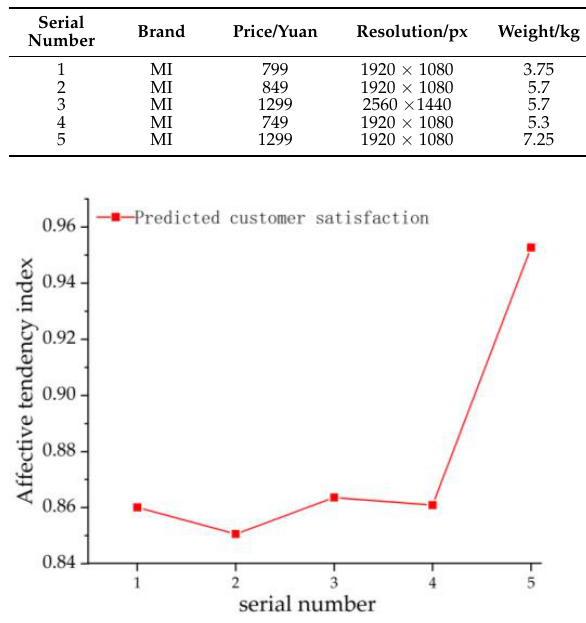
Table 5. Experimental verification data.